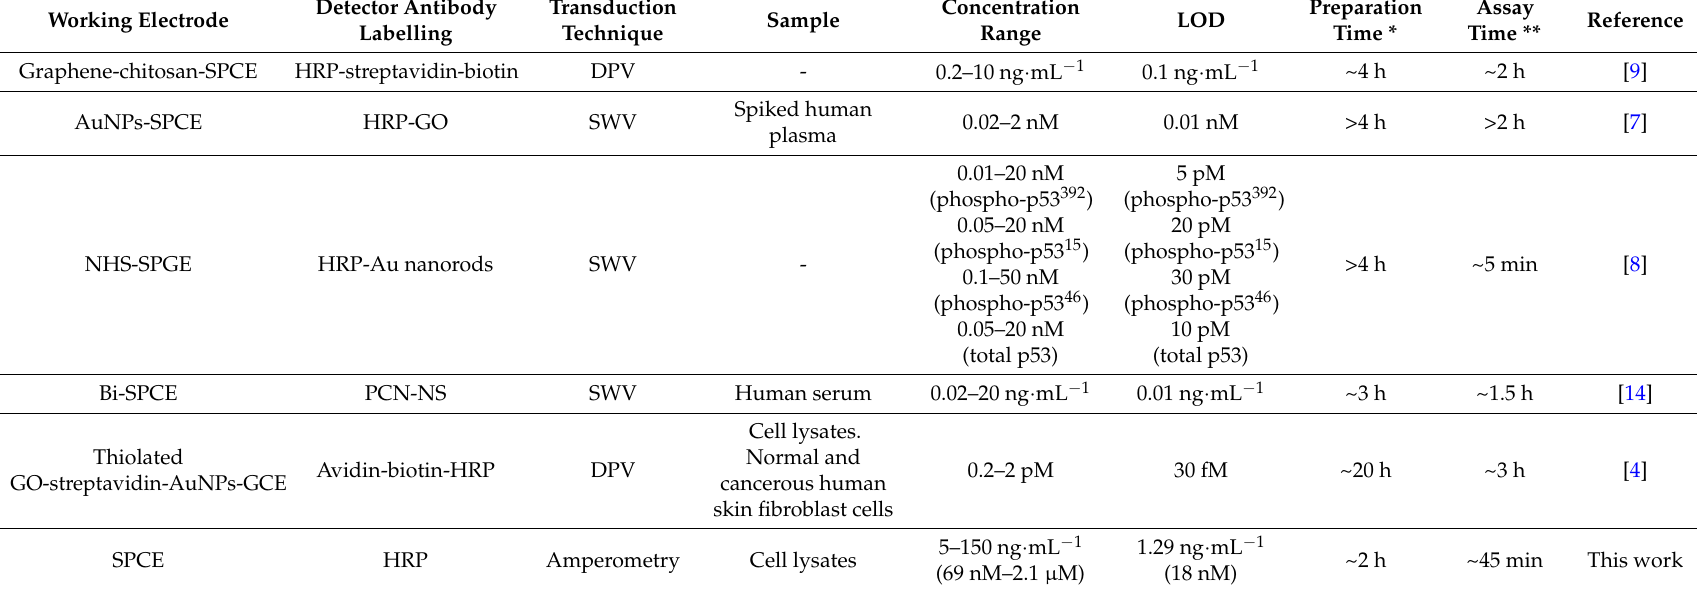
Table 2. Characteristics of electrochemical biosensors for the detection of p53